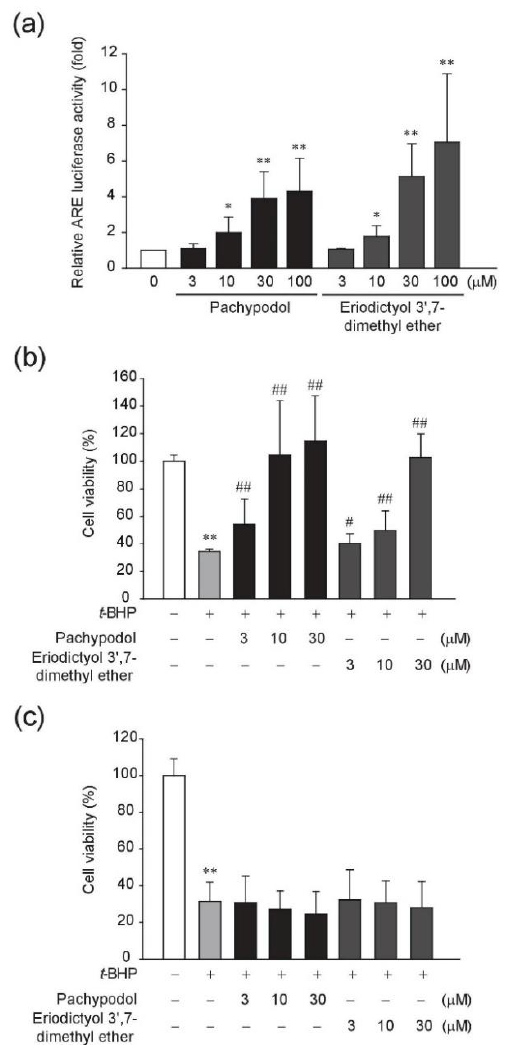
Figure 2. Effects of pachypodol and eriodictyol 3',7-dimethyl ether on the Nrf2-antioxidant response element (ARE) pathway and t -BHP-induced cell death. ( a ) The ARE-luciferase activity was measured in the lysates of HepG2 cells stably transfected with pGL4.37 plasmid. Cells were treated with each compound for 12 h. Data represent the mean ± S.D. ( n = 5); ( b , c ) HepG2 cells were preincubated with the indicated concentrations of each compound for 12 h ( b ) or 1 h ( c ) and subsequently exposed to 500 μM t -BHP for 4 h. Cell viability was determined by an MTT assay. Data represent the mean ± S.D. ( n = 8). * p < 0.05, ** p < 0.01 (compared with the DMSO-treated vehicle control); # p < 0.05, ## p < 0.01 (compared with the group treated with t -BHP alone); ARE, antioxidant response element; t -BHP, tert - butylhydroperoxide.